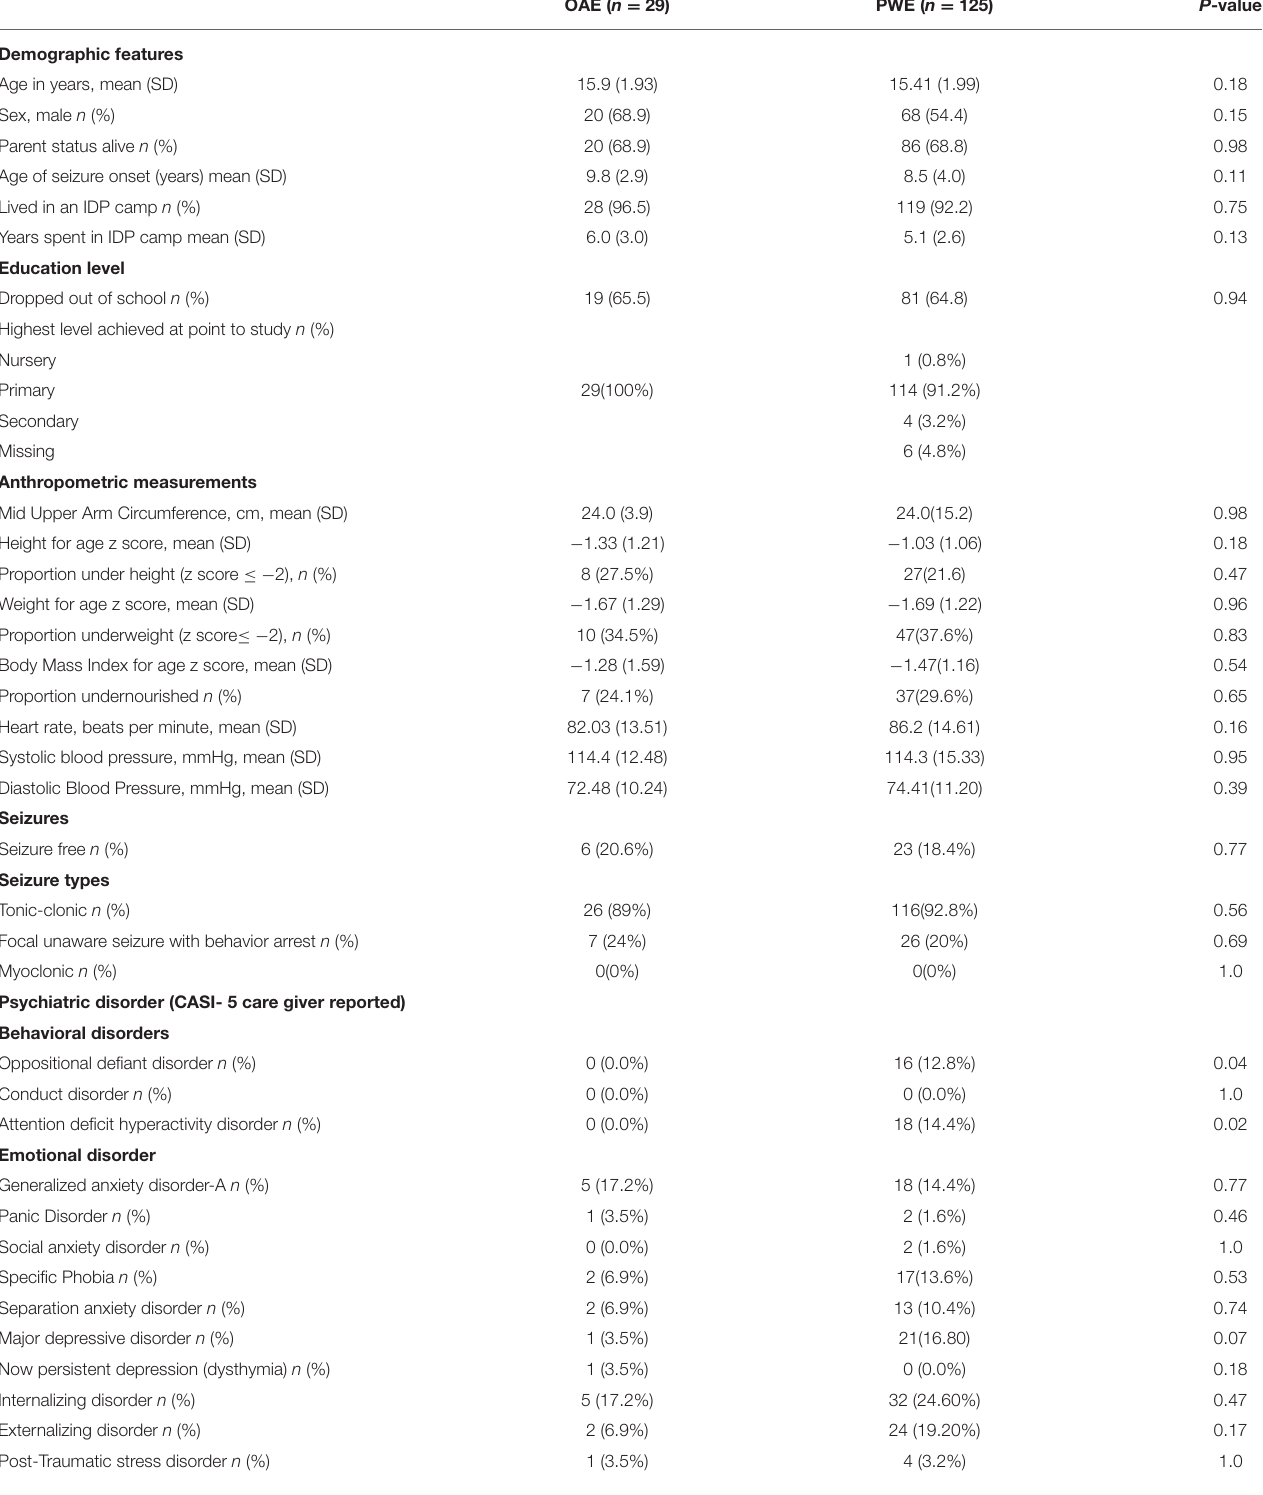
TABLE 1 | Patient